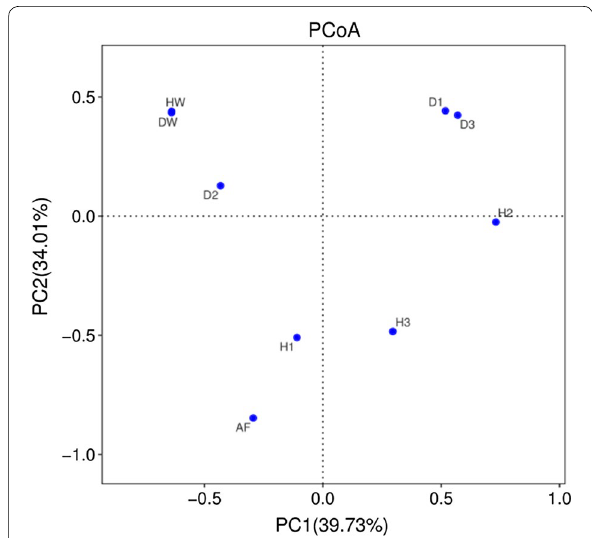
Fig. 6 Principal coordinates analysis (PCoA) plots of beta diversity based on a weighted UniFrac distance